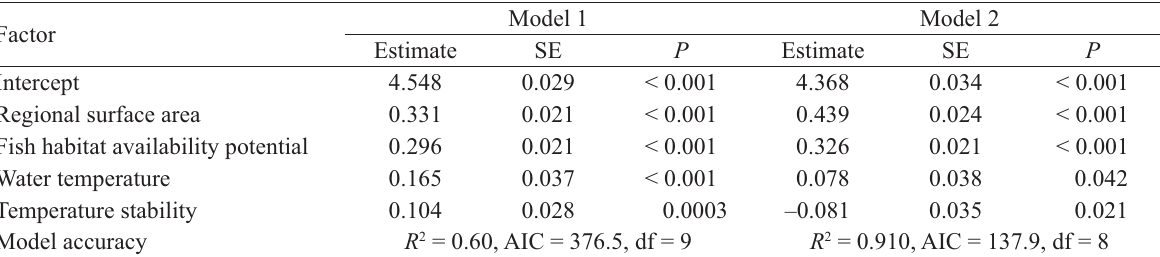
SE = standard error, R 2 = coefficient of determination, AIC = Akaike information criterion (Akaike 1974), df = degrees of freedom of residual